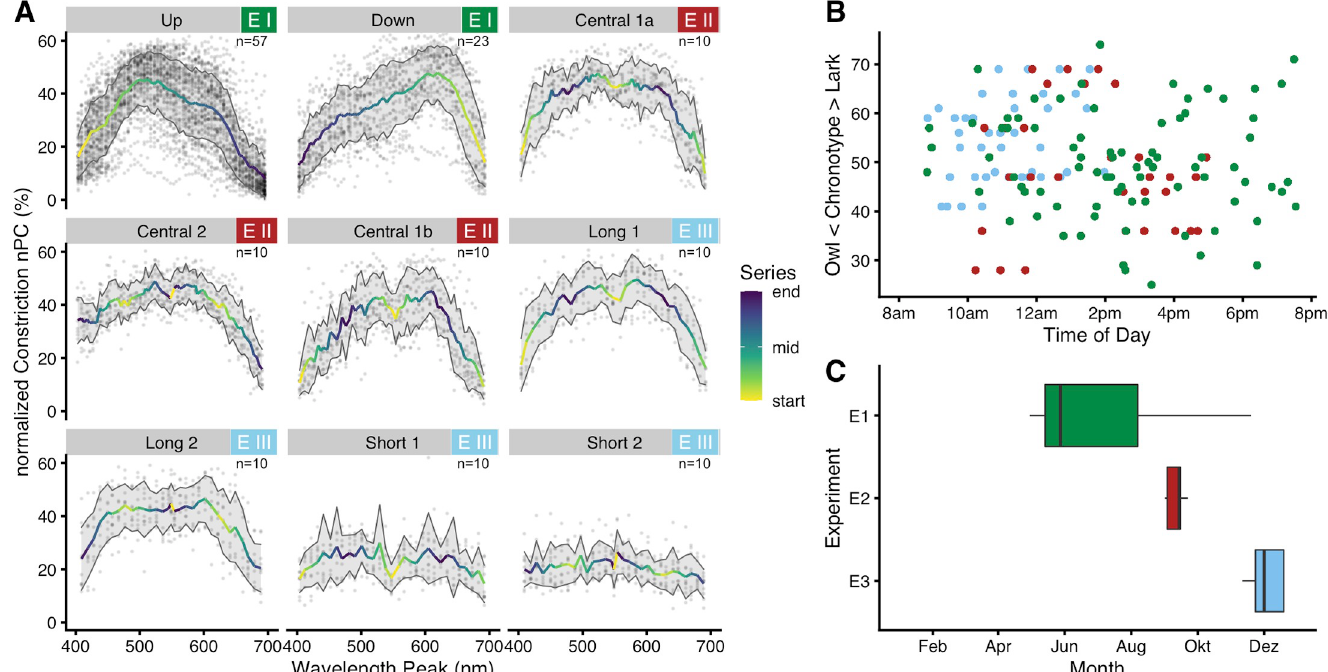
Fig 4. Experimental data and circumstances. (A) Normalized pupillary constriction (nPC) plotted against wavelength, for each of the nine protocols. The color scale shows at which point in the series a specific wavelength was presented; light yellow represents early in the series. For all but the Short protocols, points represent the average nPC during the respective last five seconds of a light step. In the two Short protocols, points represent the average nPC during the sixth second after lights-off (or sevenths second after lights-on). Traces show the mean nPC, ribbons its standard deviation. The number in the upper right corner of each plot shows the corresponding sample size. (B) Scatterplot of when subjects of a certain chronotype started their respective protocols. The color scheme is according to (C), i.e. green, red, and blue correspond to Exp. I–III, respectively. Note the lack of Lark and Owl chronotypes in Experiment I before midday. (C) Boxplot of the time of the year when the experiments took place. Preliminary measurements and parts of Experiment I took place in 2019, the other measurements in 2020.